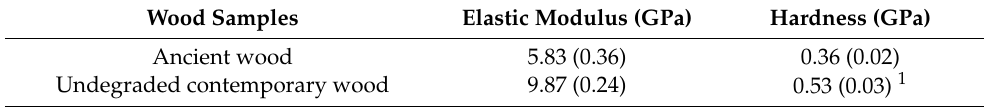
Table 2. Nanoindentation test results of ancient wood and healthy modern wood. Wood